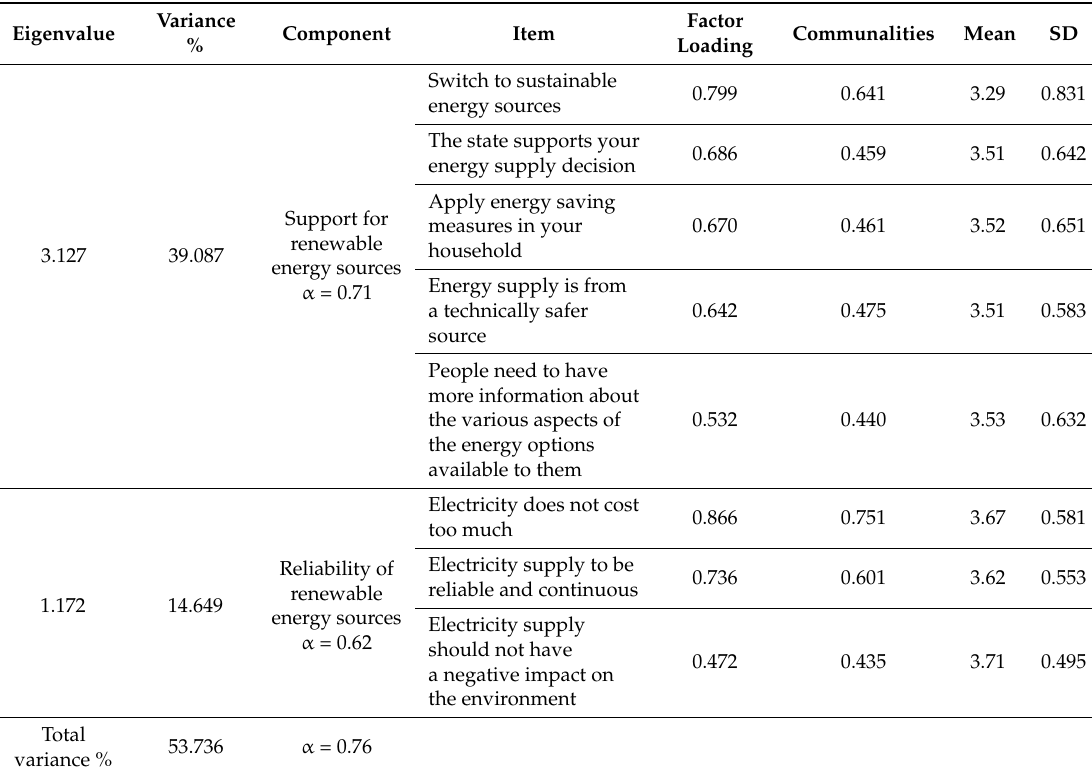
Table 7. PCA on respondents’ attitudes regarding sources of